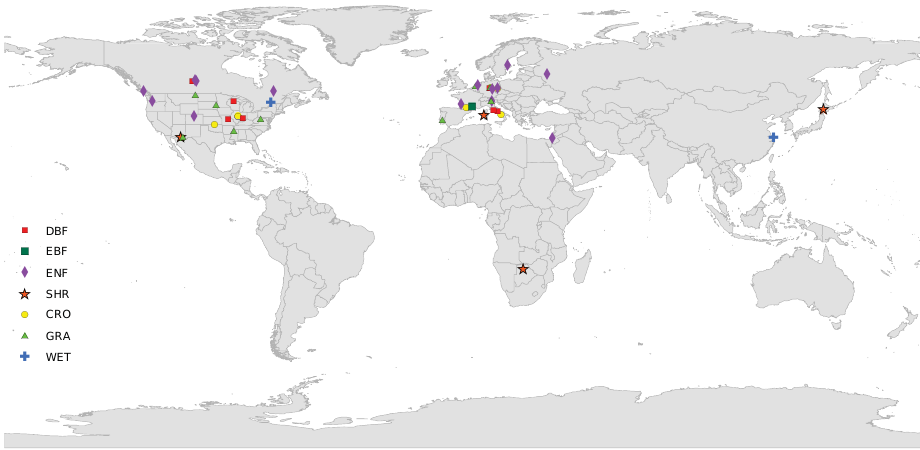
Figure 1. Location of the selected towers and their distributions for various biomes.